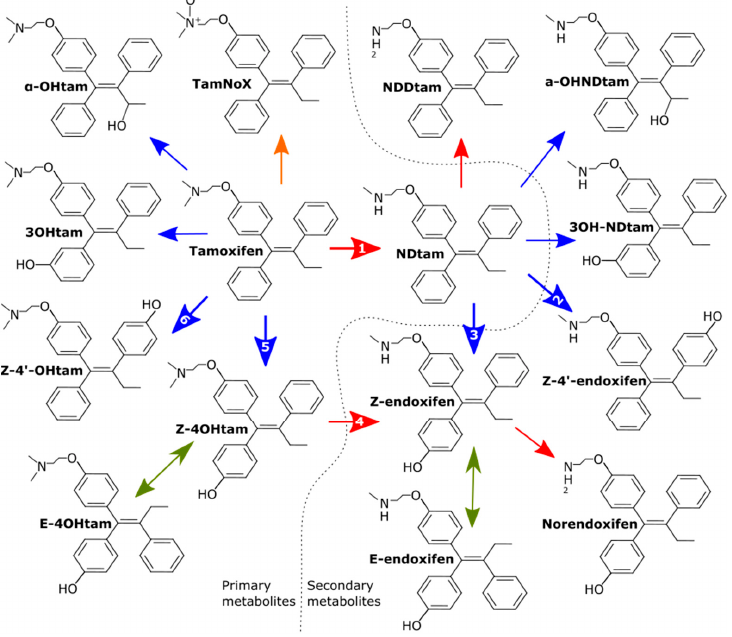
Figure 2. Overview of tamoxifen metabolites formed during first phase hepatic metabolism. Only isomers of 4OHtam and endoxifen are shown, other metabolites may also be subject to isomerism. Blue, red, orange, and green lines represent hydroxylation, demethylation, N-oxidation and non- enzymatic isomerization, respectively. Numbered arrows represent the following CYP450 enzymes involved in generation of active metabolites and their less active isomers: (1) CYP3A4/5, CYP1A1/2, CYP2C9/19, CYP2D6 (2) Unknown (3) CYP2D6 (4) CYP3A4/5, CYP2C19, CYP2D6. (5) CYP2C9/19, CYP2D6, CYP3A4, CYP2B6 (6) CYP2B6, CYP2D6. Modified from [28].